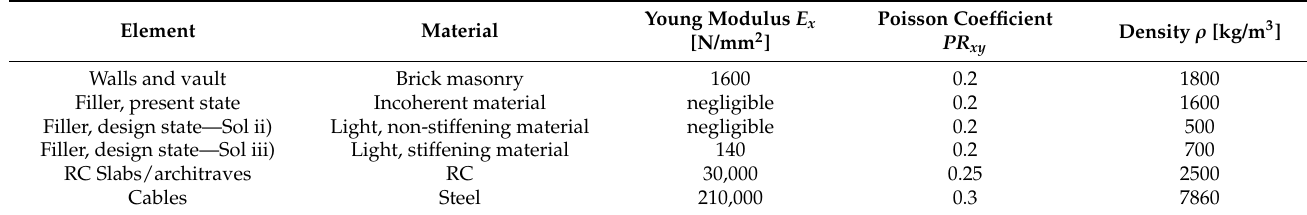
Table 9. Materials properties used in the FEM model.